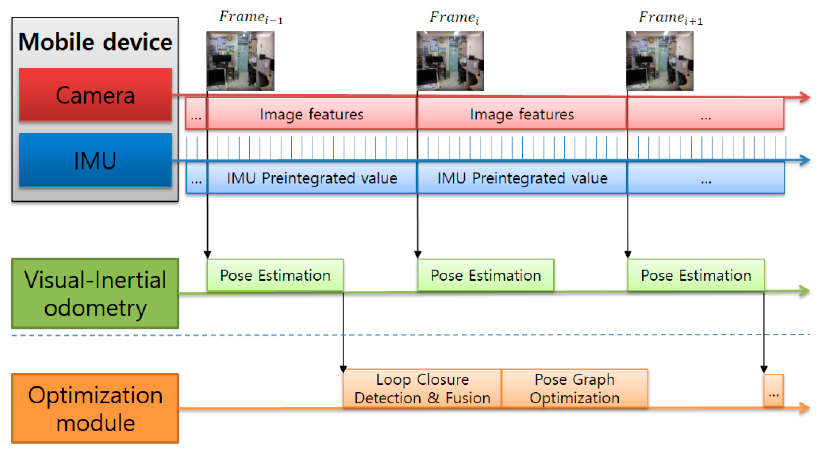
Figure 2. Structure of visual–inertial odometry.